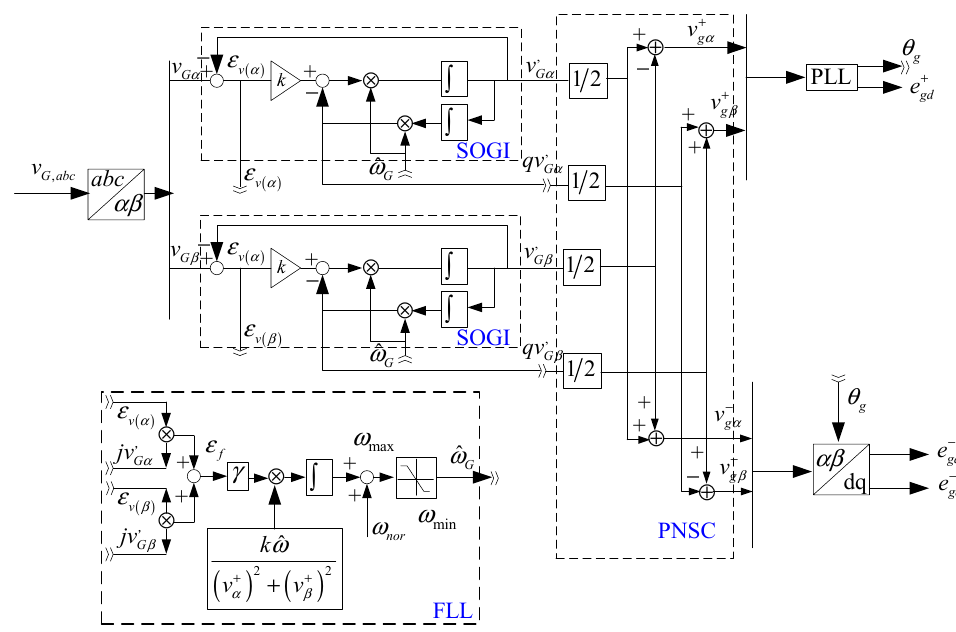
Figure 8. Block diagram of the DSOGI-FLL.